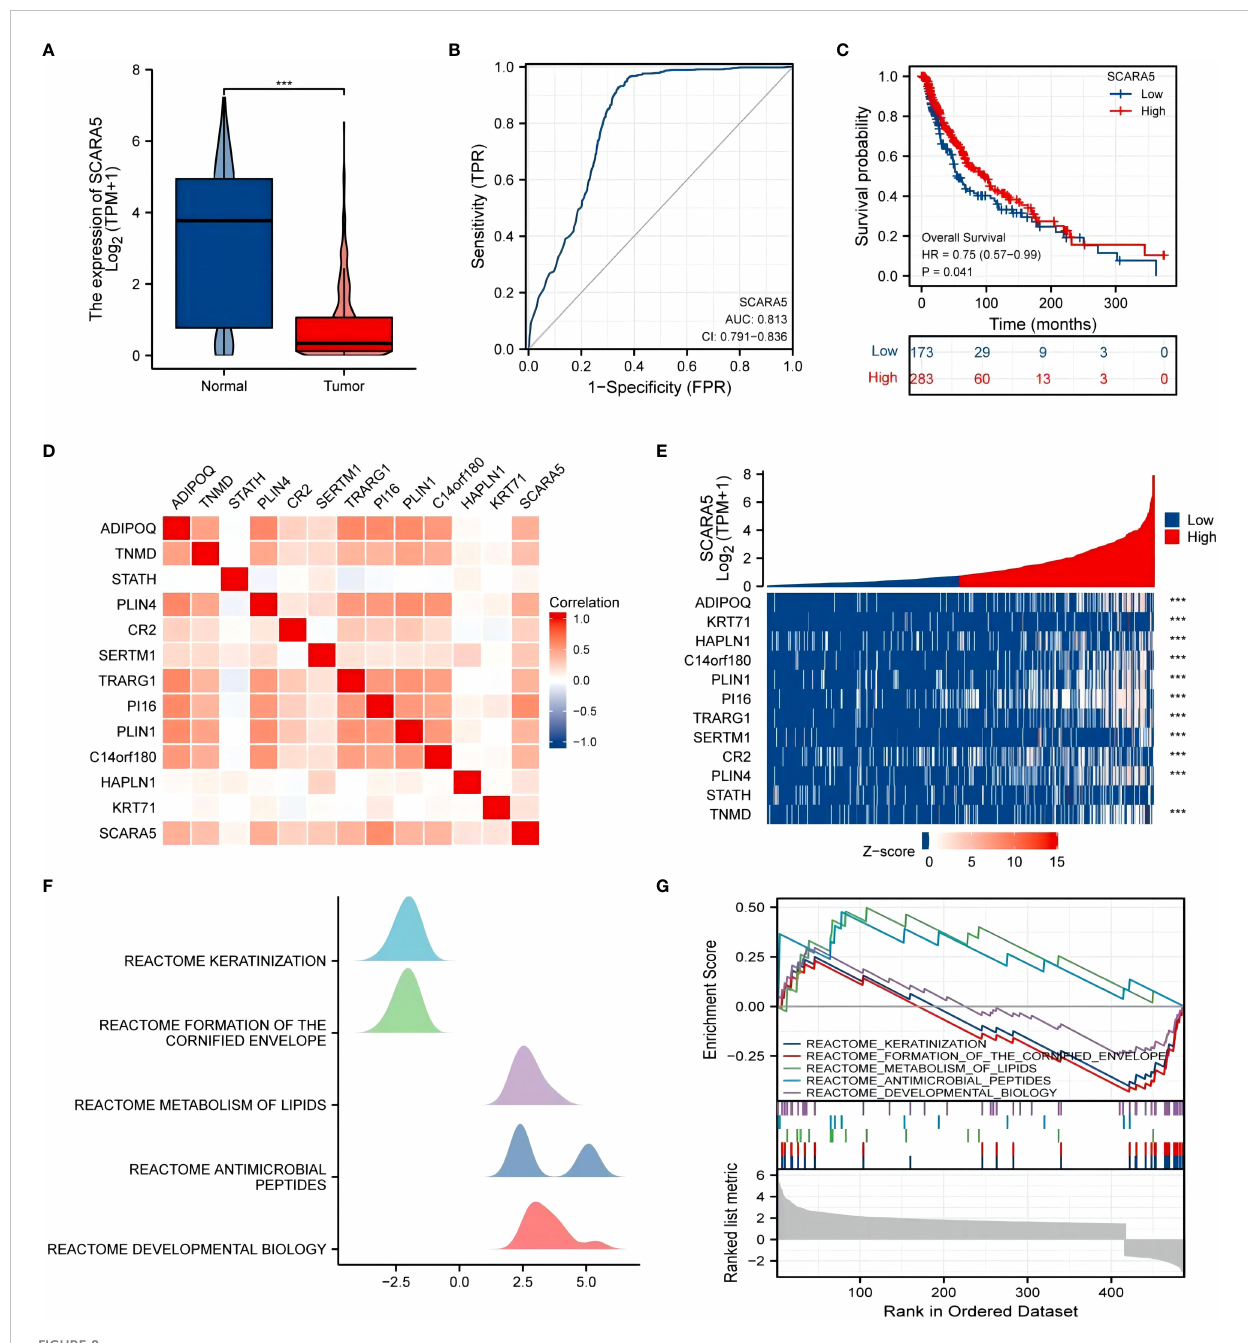
FIGURE 8 UCSC XENA (https://xenabrowser.net/datapages/) uni fi ed RNA sequencing (RNAseq) data of The Cancer Genome Atlas (TCGA) and Genotype-Tissue Expression (GTEx) in transcripts per million reads (TPM) showed that scavenger receptor class A member 5 ( SCARA5 ) levels in tumor tissue were lower than those in normal tissue, and the difference was statistically signi fi cant (*** p < 0.001), using “ ggplot2 ” for visualization (A) . The “ pROC ” package was used to analyze the diagnostic value of SCARA5 in the SKCM tumor group and the normal group, and the “ ggplot2 ” package was used to draw the receiver operating characteristic (ROC) curve (B) . The difference in survival time distribution in SKCM was statistically signi fi cant ( p = 0.04) (C) . The “ DESeq2 ” package was used to analyze the RNAseq data in the level 3 High-throughout sequencing Counts (HTSeq-Counts) format in TCGA (https://portal.gdc.cancer.gov/) SKCM and select molecules ( KRT71, HAPLN1, C14orf180, PLIN1, PI16, TRARG1, SERTM1, CR2, PLIN4, STATH, TNMD , and ADIPOQ ) with higher differences with SCARA5 used to draw a correlation heatmap (D) and single-gene co-expression heatmap (E) . The gene set enrichment analysis (GSEA) mountain map (F) and GSEA enrichment map (G)